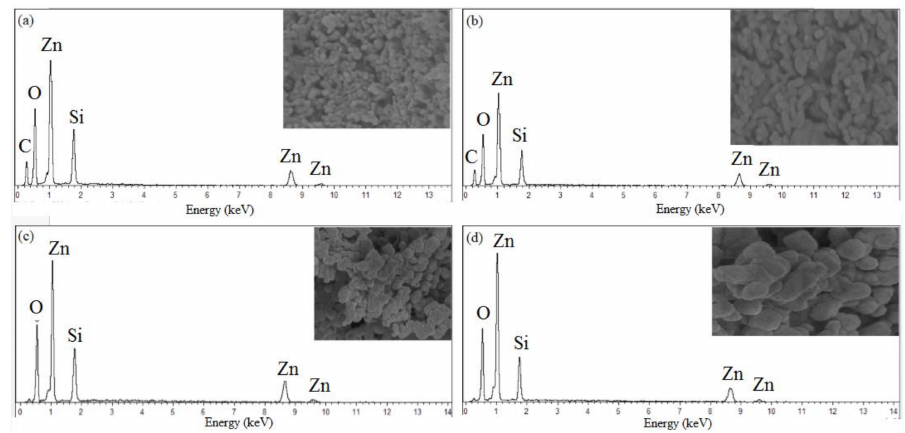
Figure 9. EDX spectrum of willemite NPs calcined at 900 ◦ C with different calcination holding times: ( a ) 1 h, ( b ) 2 h, ( c ) 3 h and ( d ) 4